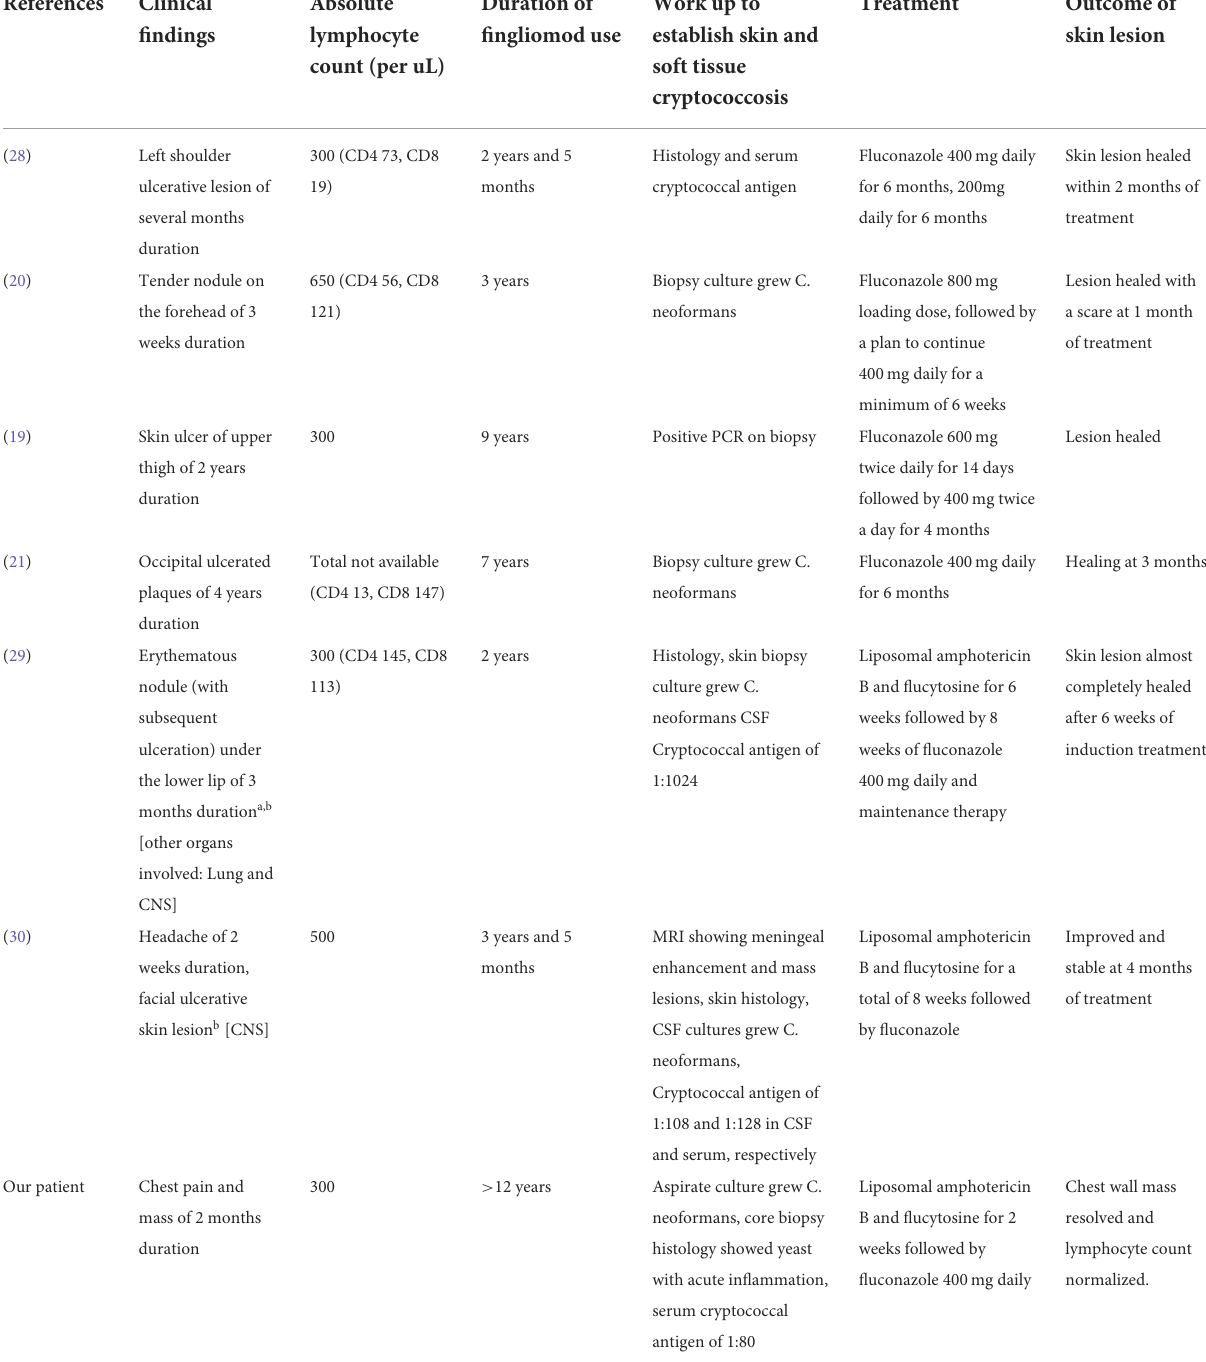
TABLE 1 Clinical characteristics, treatment, and outcome of patients with cryptococcal skin and/or soft tissue infection associated with the use of